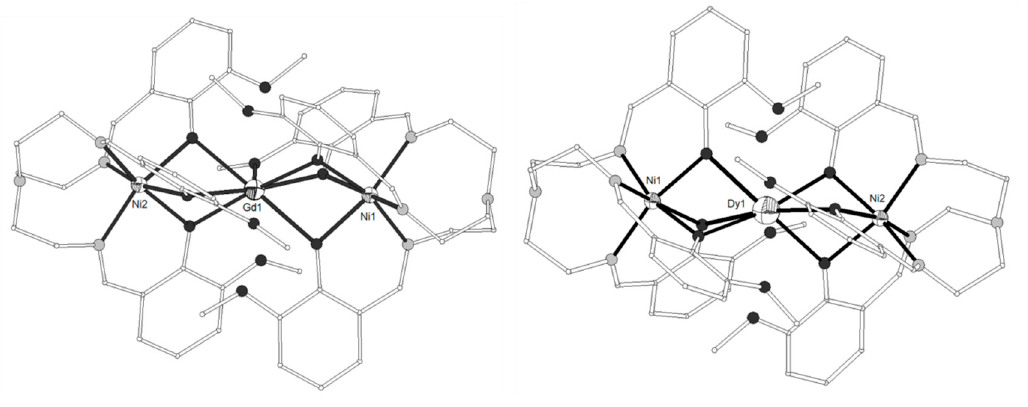
Figure 3. The molecular structures of the cations [(NiL 4 ) 2 Gd] + ( 17 , left ) and [(NiL 4 ) 2 Dy] + ( 20 , right ). Color code as in Figure 2 [22].